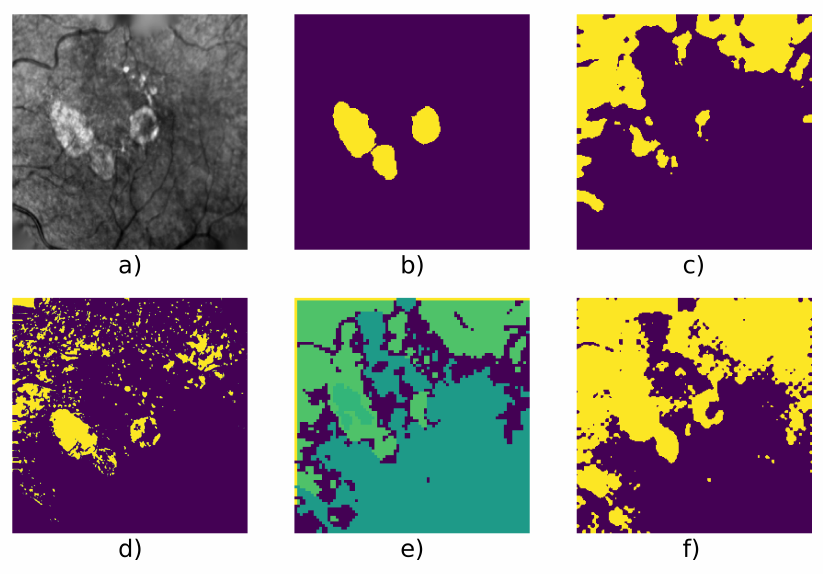
Figure 9. Patient id 020: ( a ) original image, ( b ) ground truth, ( c ) Gabor method segmentation, ( d ) W- net segmentation, ( e ) CNN + superpixel refinement segmentation, ( f ) active contour segmentation.